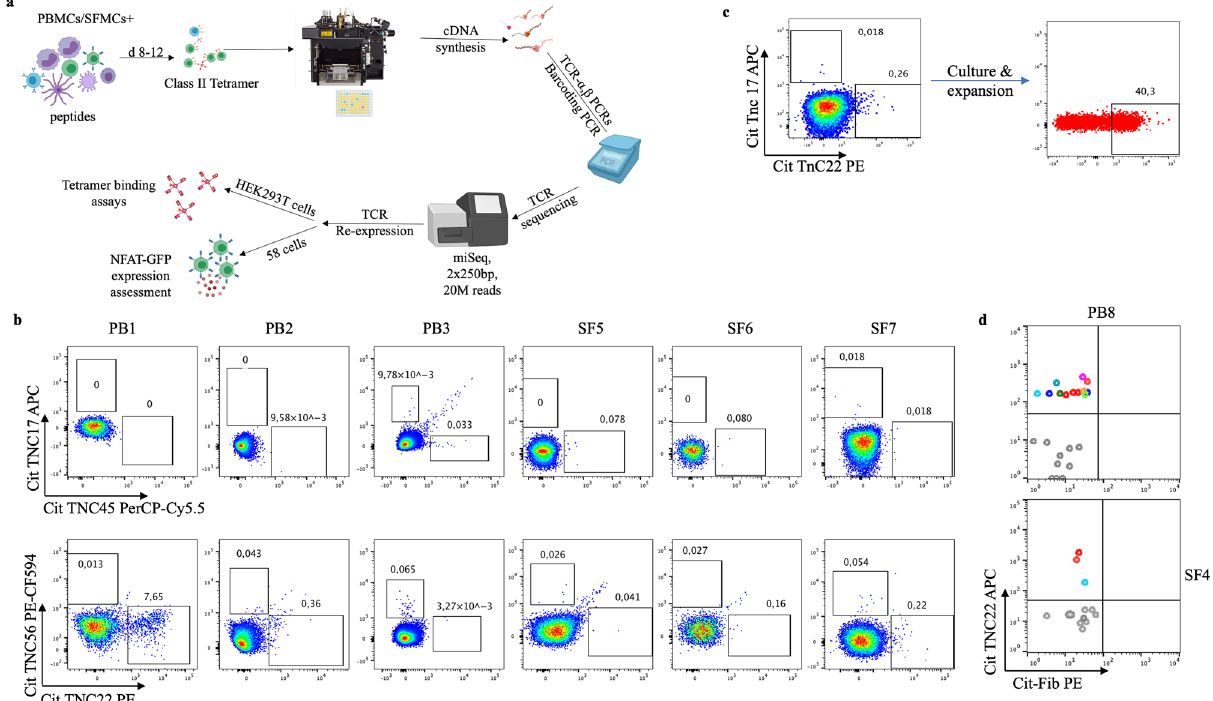
Figure 1. Generation of short-term T cell lines from RA patient material: ( a ) Overview of the TCR discovery pipeline for antigen-specific CD4 + T cells. Patient-derived primary cells are in-vitro cultured with cit-TNC peptides or control (influenza) antigens. Antigen-specific T cells are confirmed by peptide-loaded HLA- DRB1*04:01-tetramer staining, single-sorted and processed for cDNA synthesis and PCR amplifications of alpha and beta TCR genes. Barcoded PCR-products are pooled, sequenced and subsequently demultiplexed to obtain individual αβTCRs. Selected TCR sequences are artificially re-expressed either transiently in HEK293T cell line and/or stably in 58αβTCR-negative cell line 10 for validation of their ability to bind and respond to cognate peptide-MHCII complexes. ( b ) The figure shows screening for an cit-TNC specific response at day 9 of culture in the different peripheral blood (n = 3) and synovial fluid (n = 3) samples. Cit-TNC17, cit-TNC45 (top row) and cit-TNC22, cit-TNC56 (bottom row) specific cells were identified using relevant tetramers. Hereby, Cit-TNC17 + T cells were found in two samples, while 4 of the samples were found to contain cit-TNC45 specific CD4 + T cells (top row). Positive responses to cit-TNC56 was found in three samples, while cit-TNC22 + T cells were found in five samples. ( c ) Tetramer positive cells from one SF culture were bulk sorted and further expanded with PHA. The expanded cells showed extensive enrichment in proportion of cit-TNC22 specific CD4 + T cells. ( d ) This method provides a robust readout to screen immunodominant peptide being presented in an individual and downstream isolation of T-cells specific for that particular epitope. We could exemplify this strategy in one peripheral blood sample (upper panel) and one synovial fluid sample (lower panel), where we used a cocktail of 5 different citrullinated targets (fibrinogen n = 2, enolase n = 1, Tenascin C n = 2). Hereby, we retrieved TCR sequences from bright cit-TNC22 specific CD4 + T cells, both in SF (one expanded TCR present twice, red cells) and PB (two expanded clones, red and blue